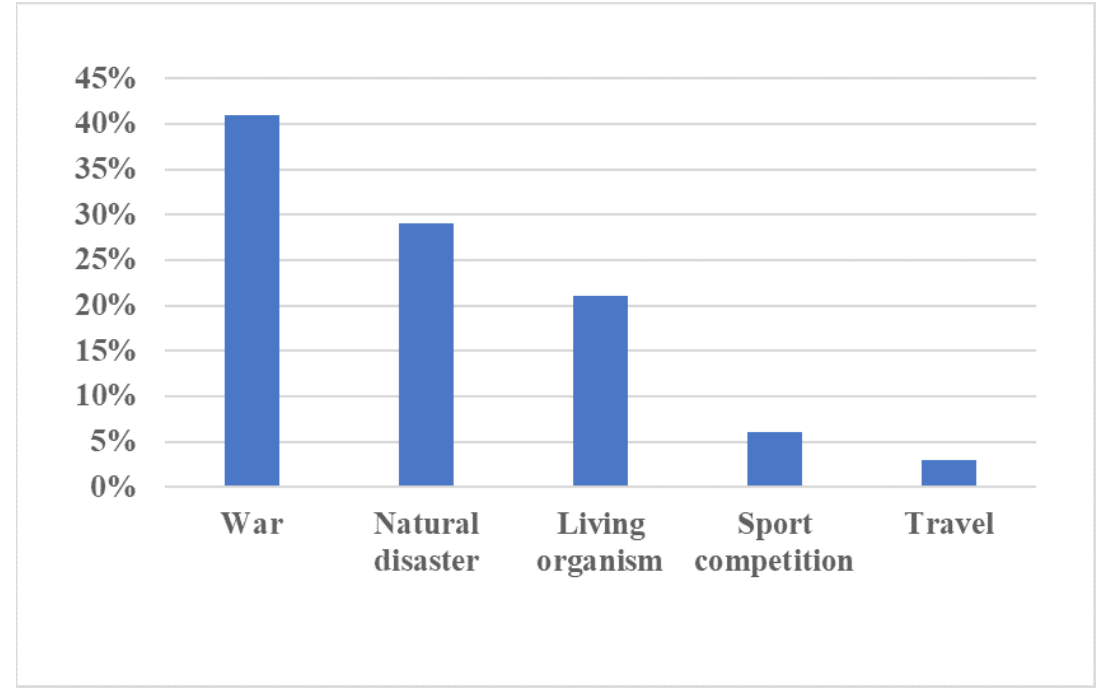
Figure 1 - Source domains of COVID-19